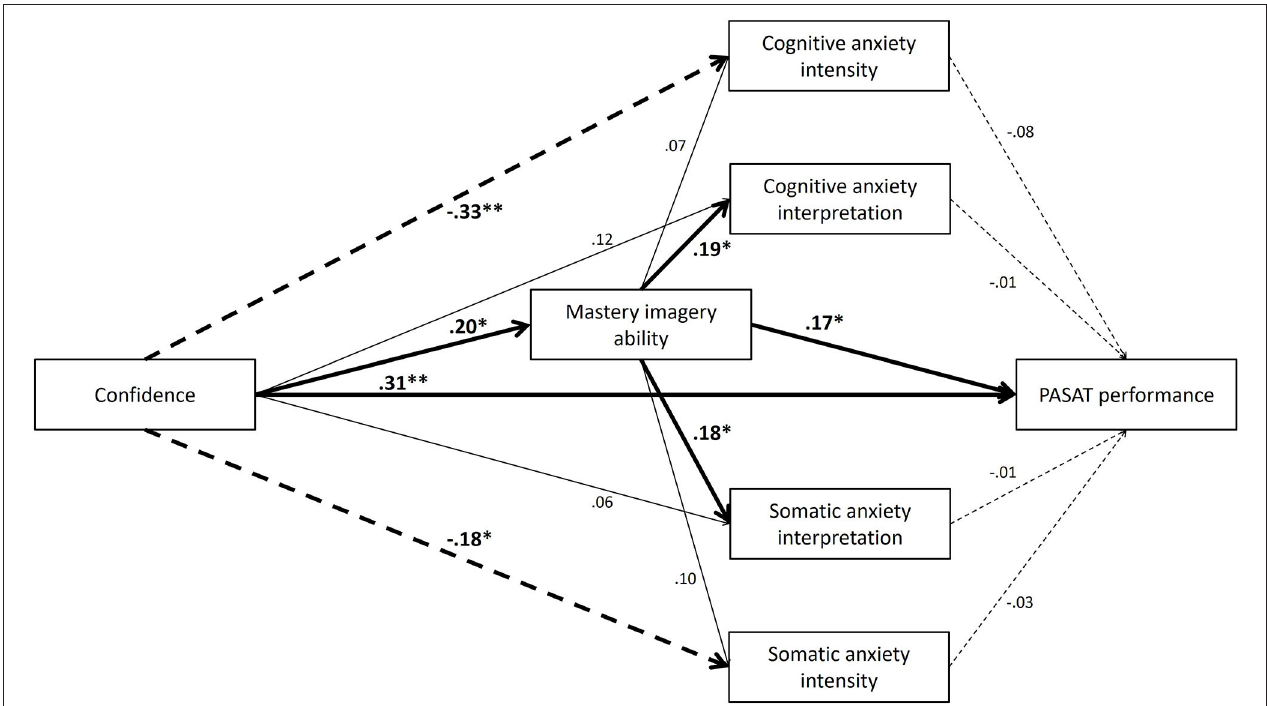
FIGURE 2 | Final model of mastery imagery ability mediating the relationship between confidence and cognitive and somatic anxiety interpretation. All values are standardized coefficients. ** p < 0.001, * p < 0.05. For visual simplicity, controlling variable gender is not presented but was included in the analyses. Full lines represent positive regressions, dashed lines represent negative